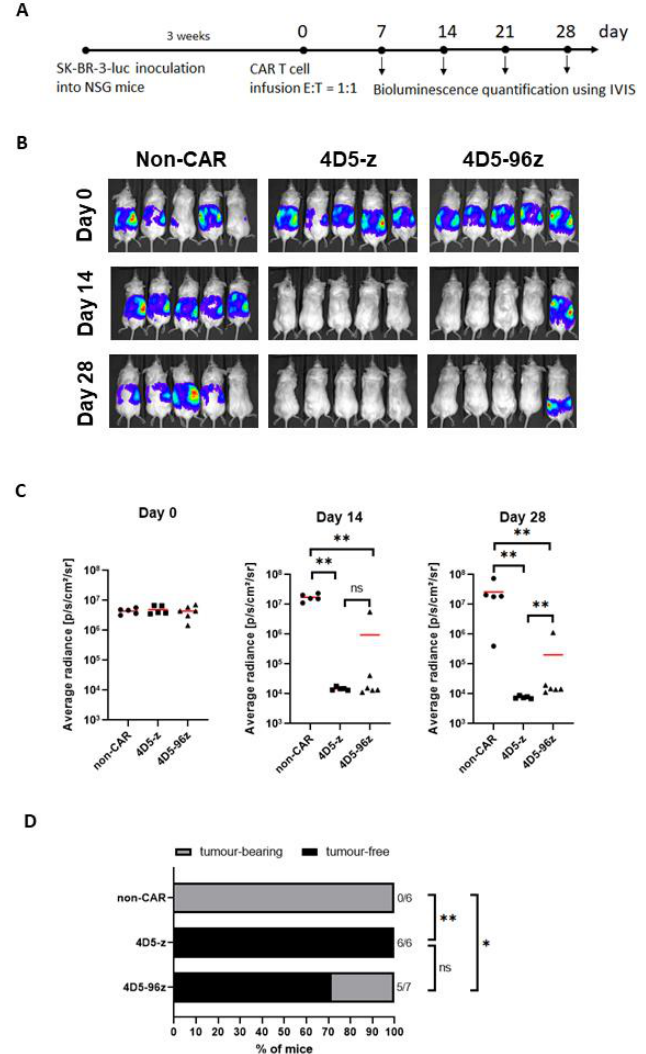
Figure 4. Incorporation of CD96 endodomain in 4D5-z CAR-T cells impairs their cytotoxicity against HER2 + tumor cells in vivo. ( A ) Schematic diagram of the tumor model using SK-BR-3 cells in NSG mice and treatment with non-CAR-T or CAR-T cells. ( B ) Selected images of tumor bioluminescence (BLI) at indicated time points (days) prior to and post T cell infusion. ( C ) Average radiance of tumor burden in mice at indicated time points post infusion of non-CAR-T, 4D5-z or 4D5-96z CAR-T cells. ( D ) Ratio of tumor-free and tumor-bearing mice of all mice examined at 14 days post T cell infusion. Data in ( B , C ) are representative of 2 independent experiments. Data in ( C ) are based on 5 or more mice analyzed with each symbol representing one mouse and red horizontal bars indicating the